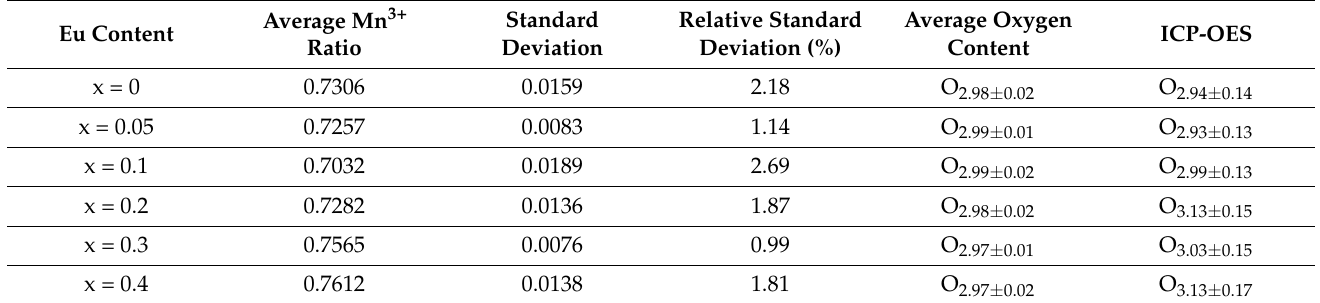
Table 3. Average oxygen content calculated using iodometry and inductively coupled plasma optical emission spectrometry (ICP-OES).